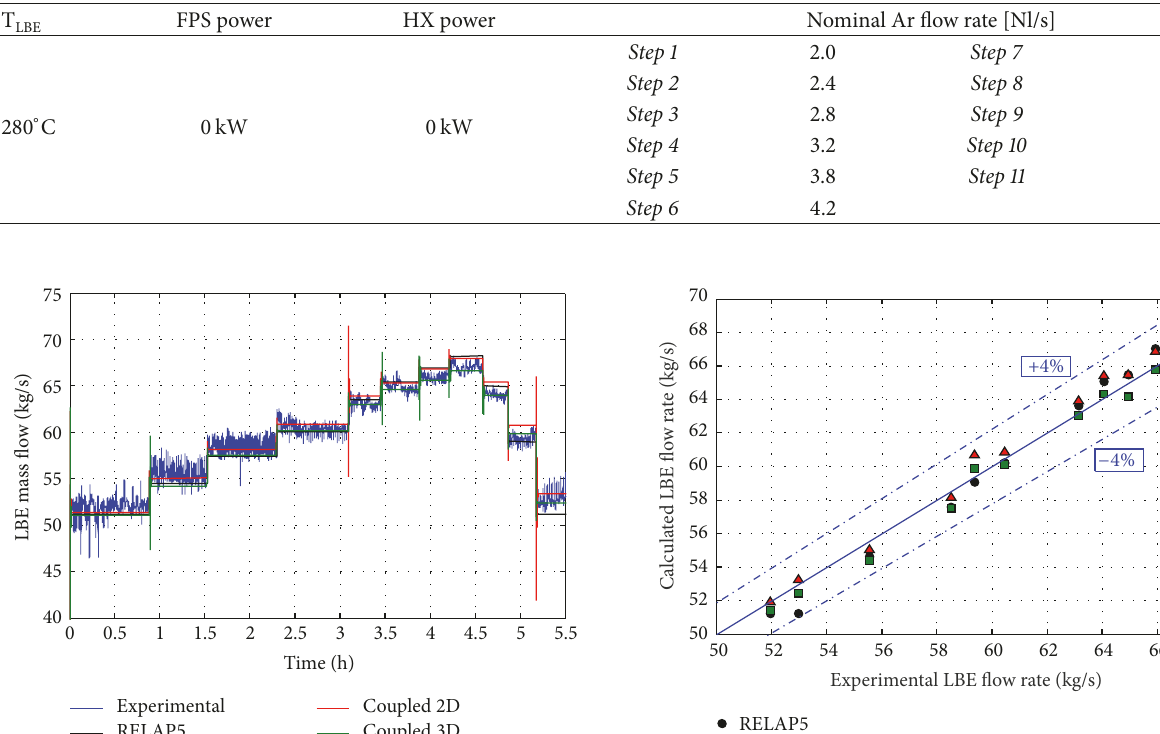
Table 2: Boundary conditions of Test F400 in CIRCE facility.